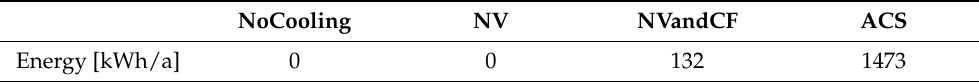
Table 9. Electrical energy consumption for the analyzed cooling concepts.